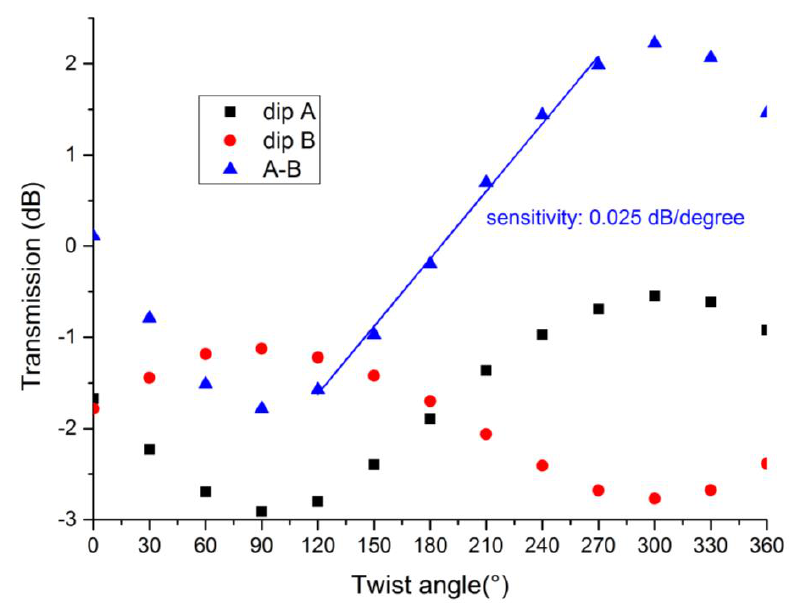
Figure 9. Depth variations of dip A and dip B under different twist angles.